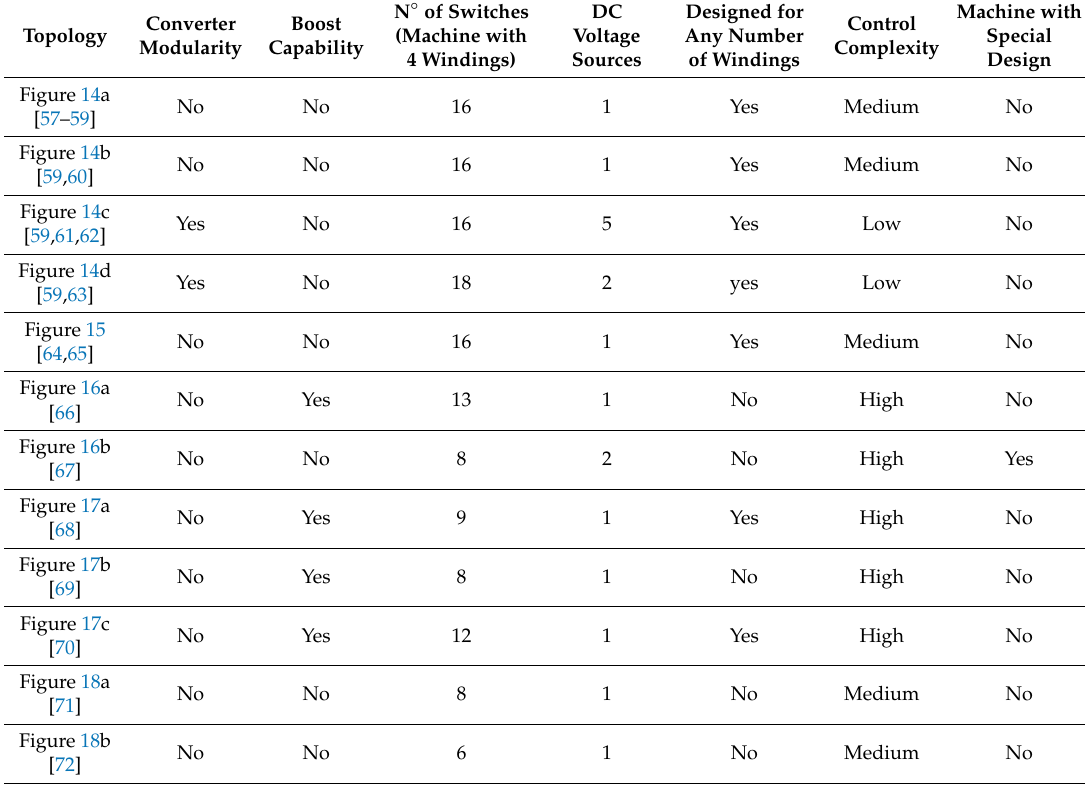
Table 2. Comparative summary of the SRM multilevel